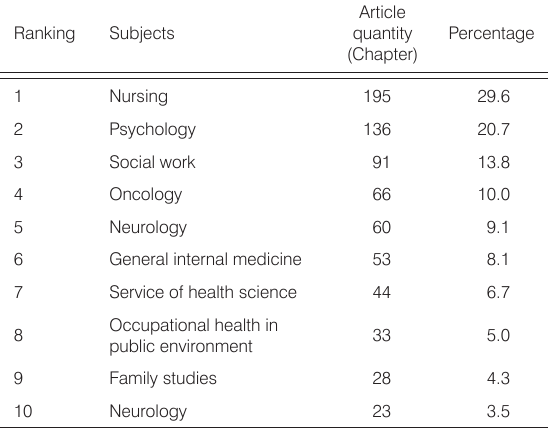
Table 3. Main directions for the study of compassion fatigue.